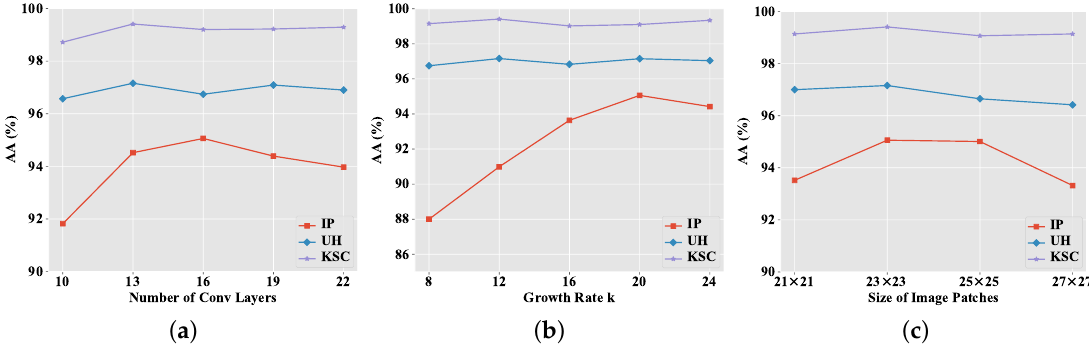
Figure 6. Influences of ( a ) the number of Conv layers, ( b ) the growth rate k , and ( c ) the size of image patches on the classification performance (average accuracy (AA) in %) of the proposed